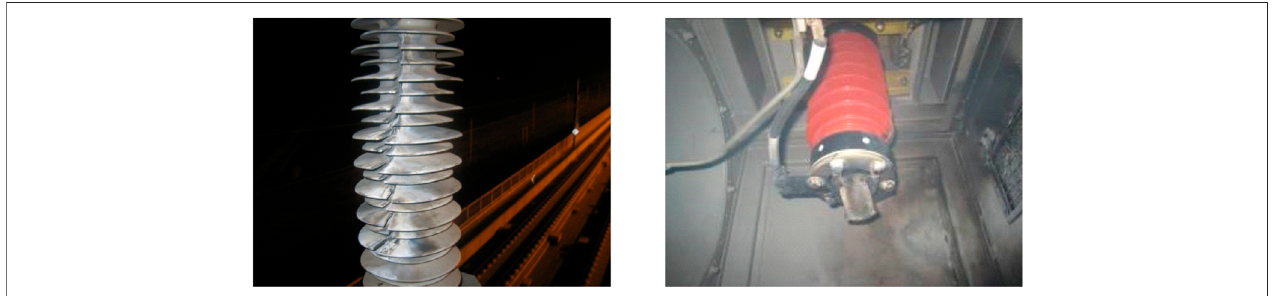
FIGURE 1 | The high-voltage equipment destroyed by the harmonic